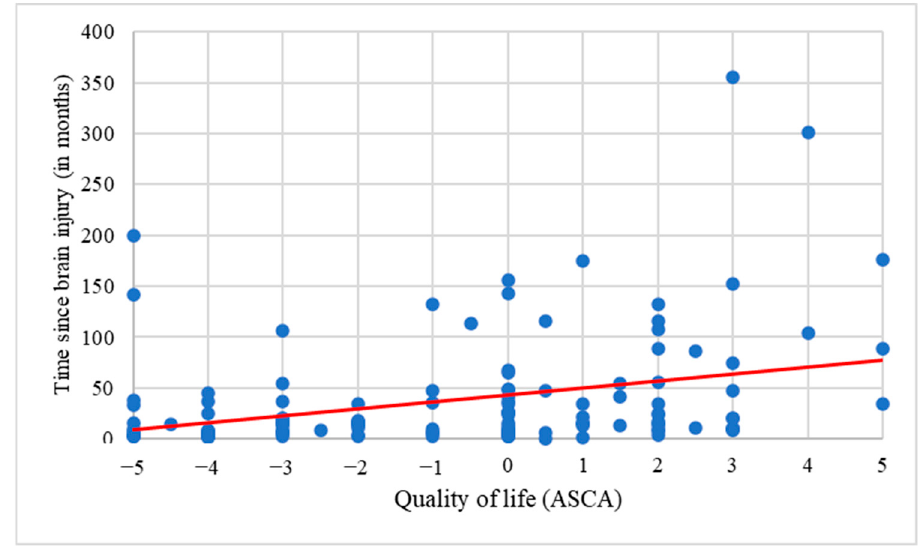
Figure 4. Correlation between QoL and time since brain injury (r = 0.038, p < 0.001).